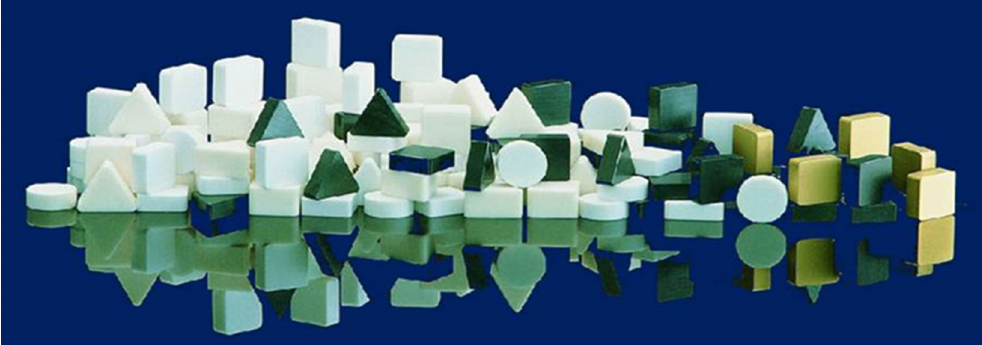
Figure 14. Tool inserts made of ceramics.